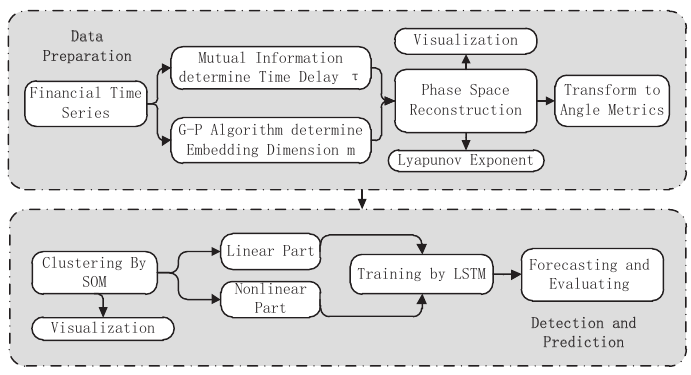
Figure 1. The proposed methodological